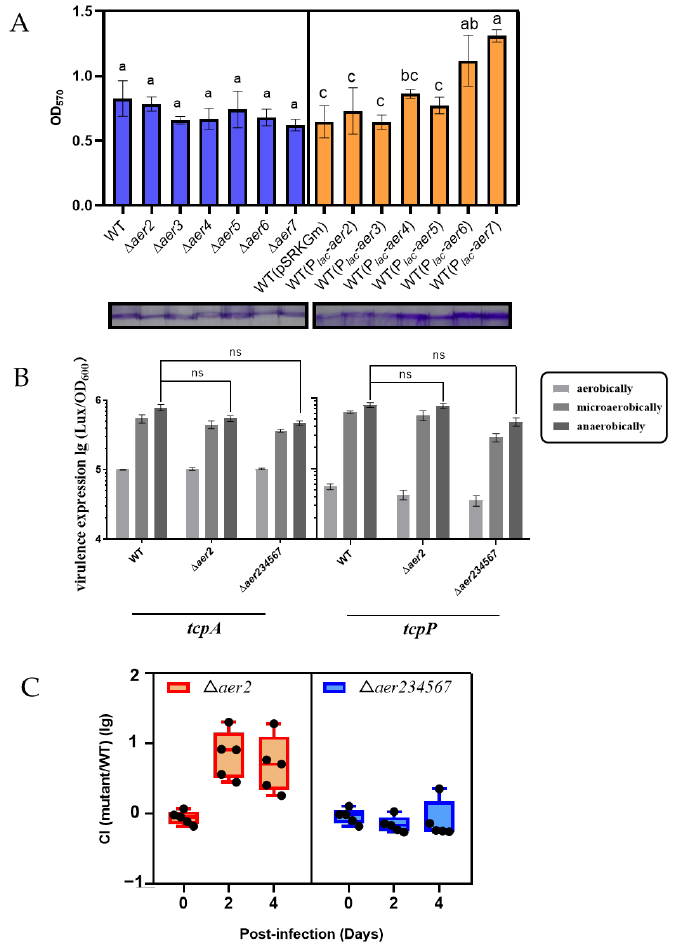
Figure 5. Effect of the aer genes on the colonization and pathogenesis of V. cholerae C6706. ( A ) Biofilm of mutant strains (blue bar) and complemented strain (orange bar). Overnight bacterial cultures were inoculated in the LB medium and grown at 37 °C for 24 h. Tubes were stained with crystal violet. Different letters in each column indicate significant differences between treatments (One-way ANOVA; p < 0.05). ( B ) Virulence gene expression under different oxygen conditions. Overnight bacterial cultures were inoculated into the virulence-inducing AKI medium (1:10,000). Cultures were grown aerobically (shaking), micro-aerobically (standing), and anaerobically (chamber, standing) at 37 °C. Luminescence was measured and normalized to OD 600 . ns, no significant difference (Student t -test). ( C ) Bacterial colonization in adult mice. Mice were intragastrically administered with 10 8 cells of a 1:1 mixture of wild type and Δ aer2 or Δ aer234567 mutant. CFU of fecal pellets were determined using a selective medium. The competitive index was calculated as the ratio of mutant to wild-type colonies normalized to the input ratio. Horizontal line: mean of values obtained for five